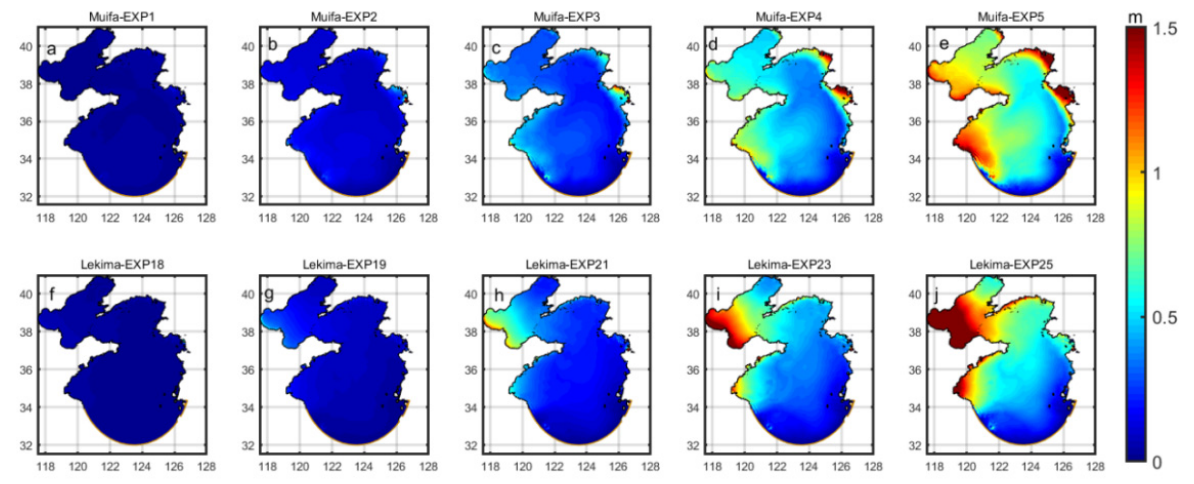
Figure 9. Spatial distribution of the storm surge when the maximum wind speed was ( a ) 10 m/s, ( b ) 20 m/s, ( c ) 30 m/s, ( d ) 40 m/s, and ( e ) 50 m/s for Typhoon Muifa and ( f ) 10 m/s, ( g ) 20 m/s, ( h ) 30 m/s, ( i ) 40 m/s, and ( j ) 50 m/s for Typhoon Lekima.